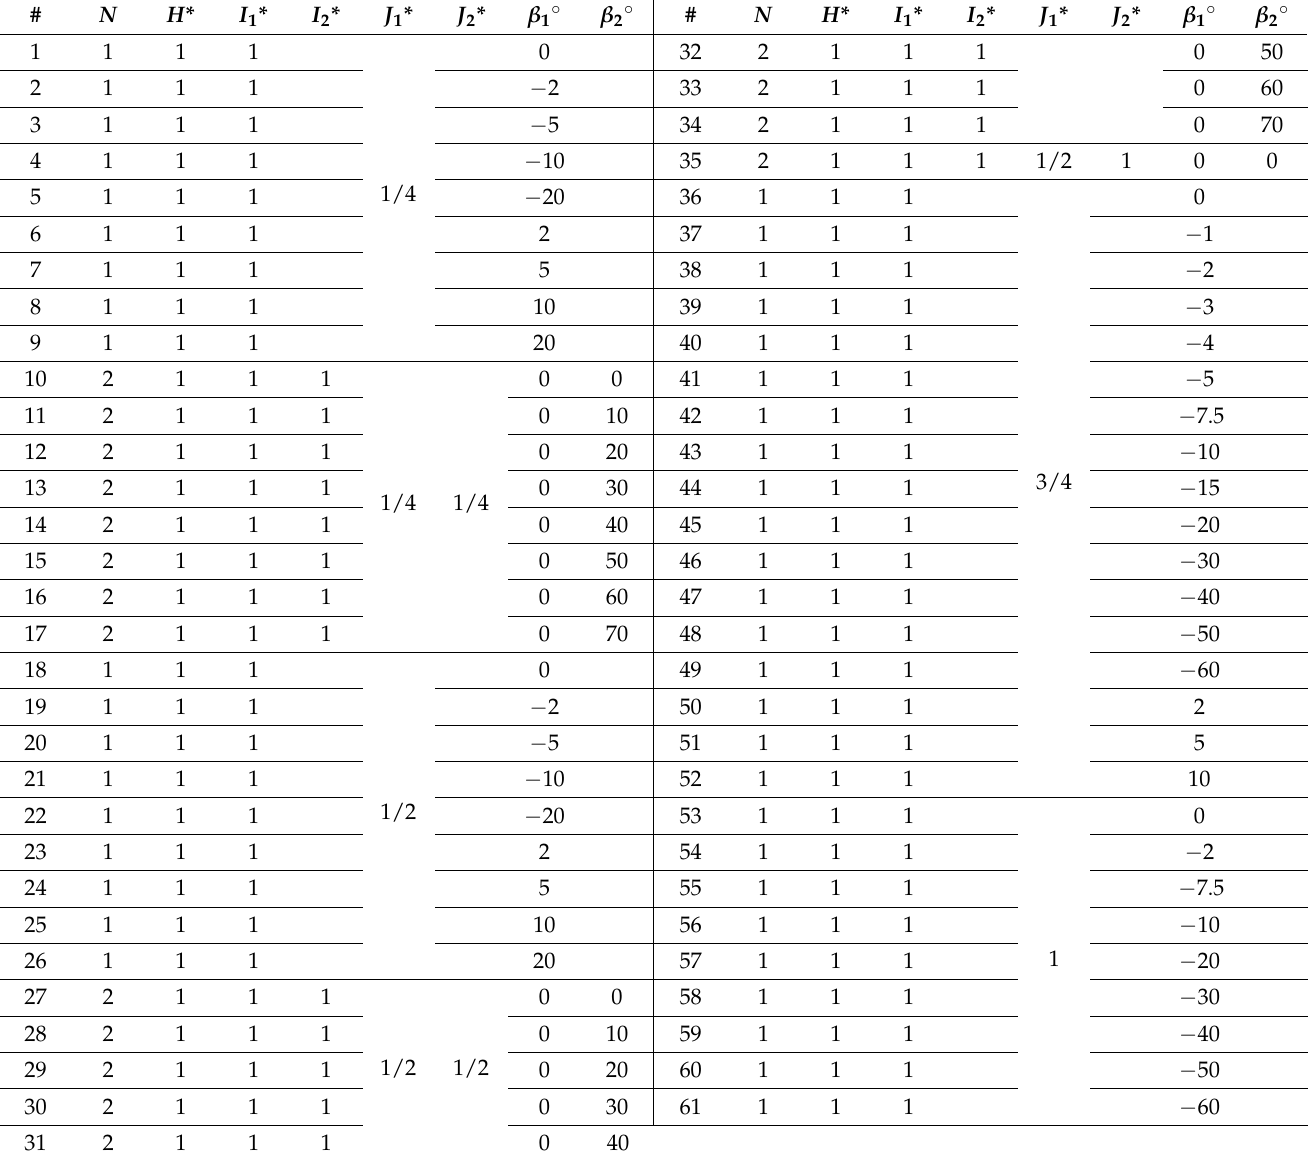
Table 2. Parameters of the upstream deflector at various